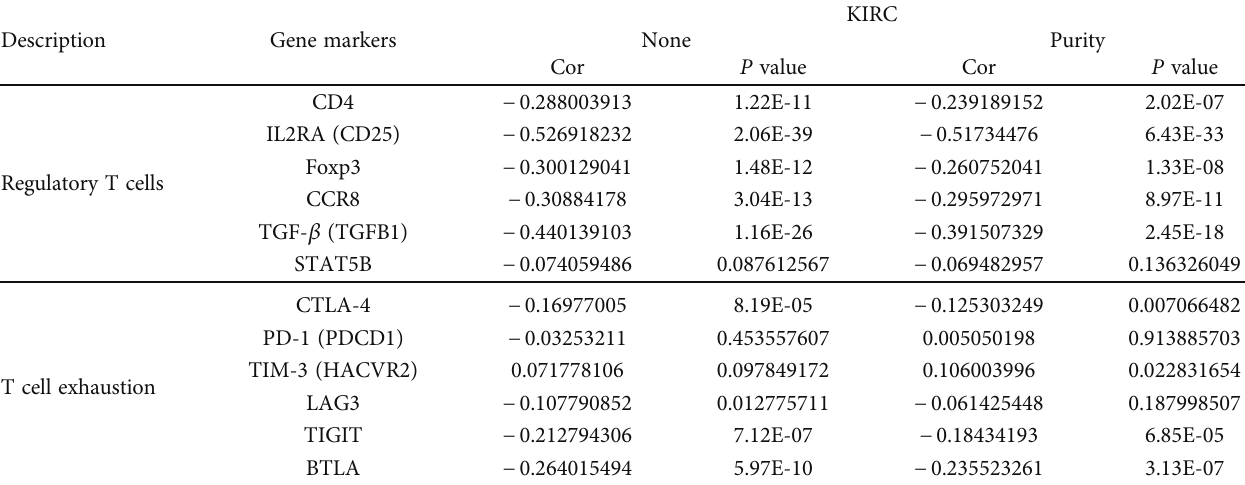
Table 3: Correlation analysis between FXYD2 and gene markers of regulatory T cells and T cell exhaustion in the TIMER database.